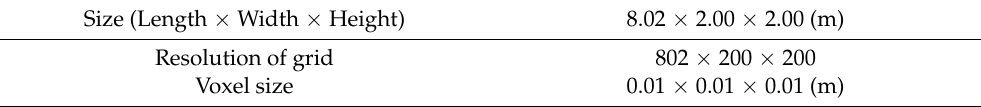
Table 1. Geometrical information of the workspace.